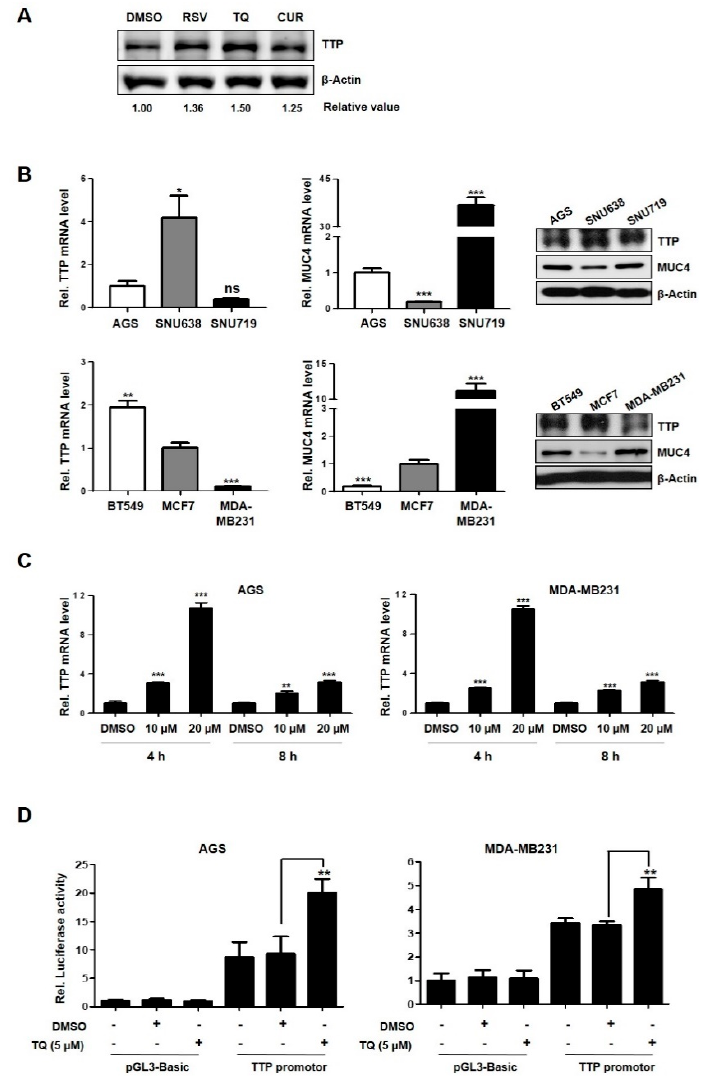
Figure 1. Thymoquinone (TQ) regulates MUC4 expression through the induction of tristetraprolin (TTP) expression. ( A ) AGS cells were treated with Resveratrol 20 µ M, TQ 5 µ M, curcumin 10 µ M to induce TTP expression. TTP protein expression levels were confirmed by western blotting. The relative protein band density of TTP was normalized to β -Actin. ( B ) The endogenous level of TTP and MUC4 expression in gastric and breast cancer cell lines to qRT-PCR and western blotting. ( C ) AGS and MDA-MB231 cells were treated with TQ in a dose-dependent manner for 4 and 8 h. The mRNA level of TTP was determined by qRT-PCR as compared with DMSO as a control. β -actin was detected as a control for qRT-PCR. ( D ) AGS and MDA-MB231 cells were transfected with pGL3 / TTPp-1411 containing the TTP promoter ( − 1343 to + 68) for 24 h and then treated with TQ 5 µ M. After treatment with TQ for 4 h, luciferase activity was measured. The expression levels obtained from pGL3 basic transfected cells without TQ treatment were set to 1. Each bar represents the mean ± S.D. of three independent experiments. Each bar represents the mean ± S.D. of three independent experiments. (* p < 0.05; ** p < 0.01; *** p < 0.001).